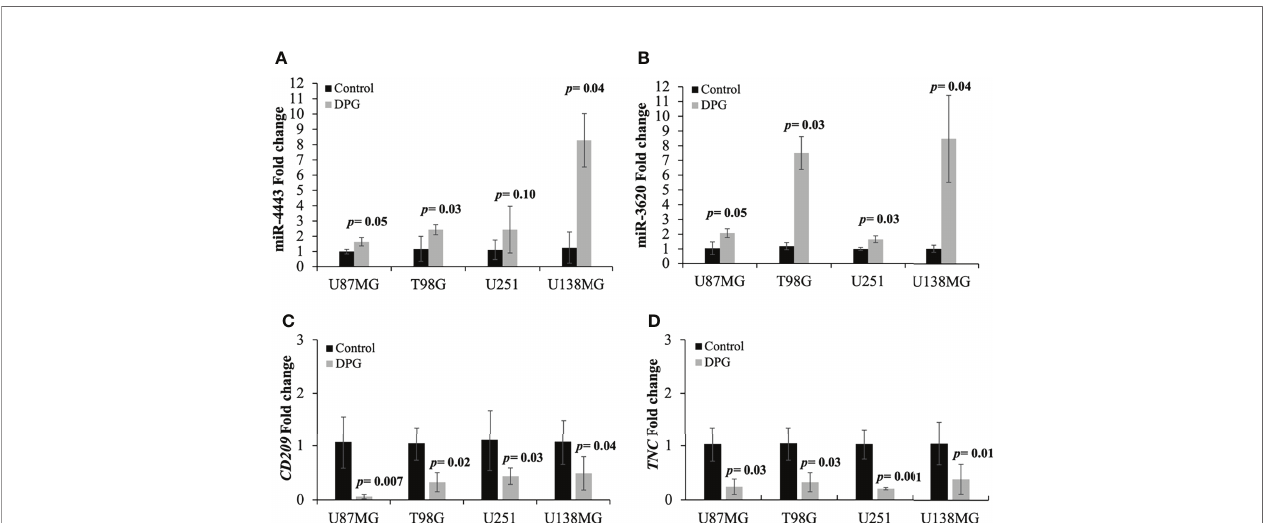
FIGURE 4 | Dipotassium glycyrrhizinate (DPG) modulated the expression of selected miRNAs and their respective target genes in glioblastoma cell lines (GBM). (A) U87MG (1.64 vs . 1.00, p -value = 0.05), T98G (2.44 vs . 1.17, p -value = 0.03), U251 (2.44 vs . 1.11, p -value = 0.11), and U138MG 8.27 vs . 1.25, p -value = 0.04) cell lines treated with DPG showed an increased level of miR-4443 expression compared to untreated control cells. (B) U87MG (2.08 vs . 1.04, p -value = 0.05), T98G (7.50 vs . 1.19, p -value = 0.007), U251 (1.66 vs . 1.00, p -value = 0.03), and U138MG (8.47 vs . 1.00, p -value = 0.03) cell lines exposed to DPG showed increased miR-3620 expression levels compared to untreated control cells. (C) Decreased CD209 (0.06 vs . 1.07, p -value = 0.007; 0.32 vs . 1.04, p -value = 0.002; 0.44 vs . 1.11, p -value = 0.03; 0.49 vs . 1.07; p -value = 0.04) and (D) TNC (0.24 vs . 1.03, p -value = 0.03; 0.05 vs . 1.15, p -value = 0.03; 0.20 vs . 1.03, p -value = 0.001; 0.39 vs . 1.06; p -value =